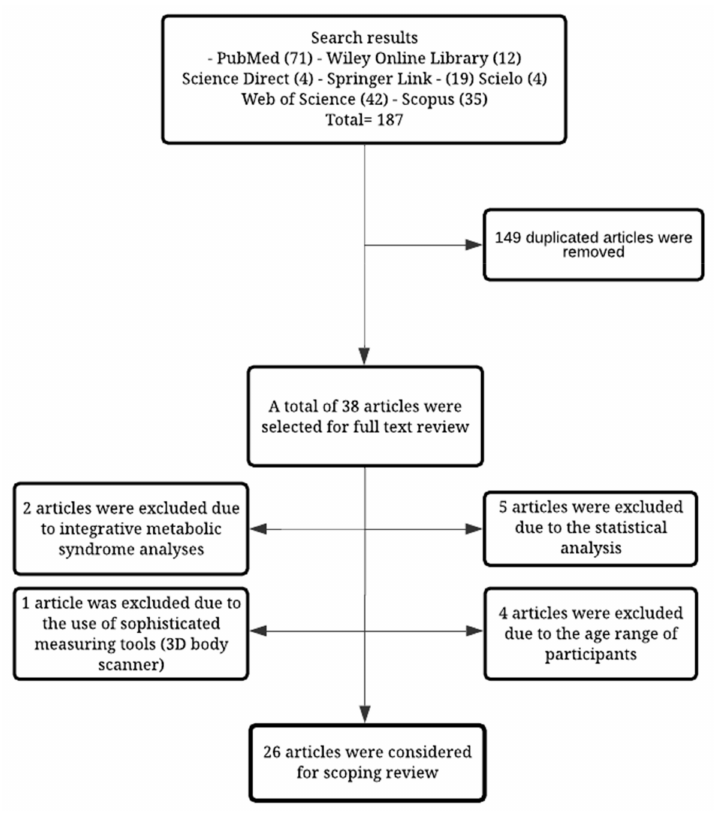
Figure 1. Flow chart of the literature search